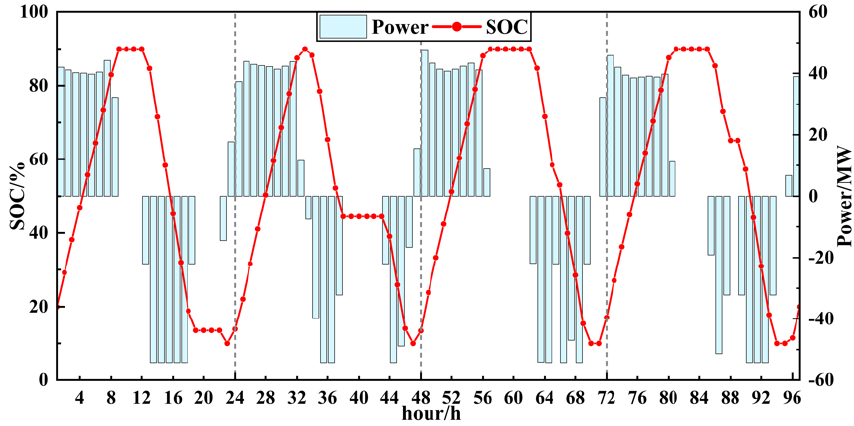
Figure 11. Optimal scheduling of the EES at Bus 3.